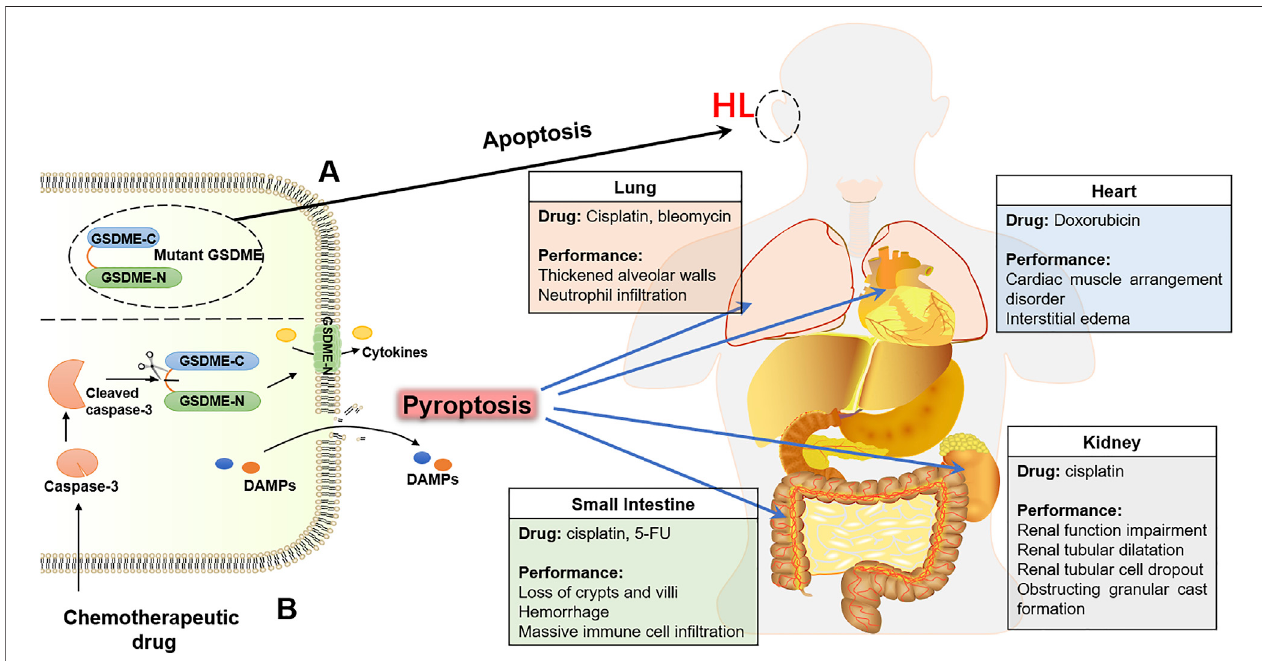
FIGURE 3 | The GSDME contributes to the HL and toxicity of chemotherapy. (A) Mutant GSDME in connection with HL. (B) Chemotherapeutic drugs damage normal tissues by activating GSDME-mediated pyroptosis, including lung, heart, small-intestine and kidney.